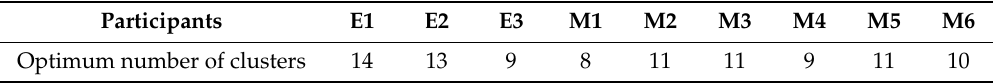
Table 2. The optimum number of clusters for all participants (E1–3: electric wheelchair user, M1–6: manual wheelchair user).